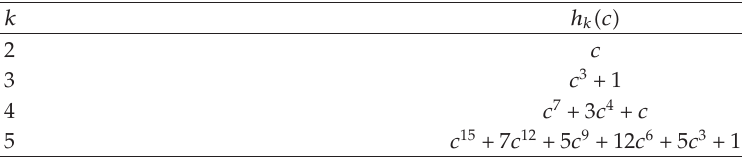
Table 6: Expression of h k (cid:2) c (cid:4) when α (cid:3) −